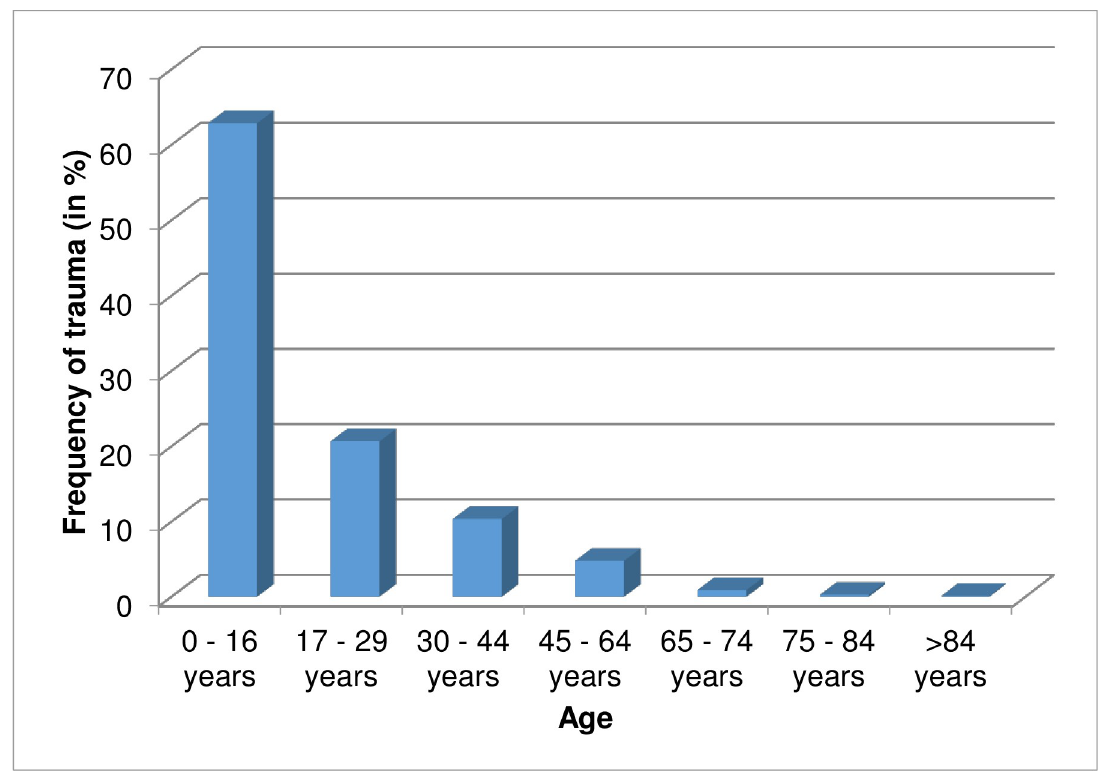
Fig 1. Age of ocular trauma patients at Hawassa University, Referral Hospital, from January 01, 2012 to July 31, 2014 (N = 773).